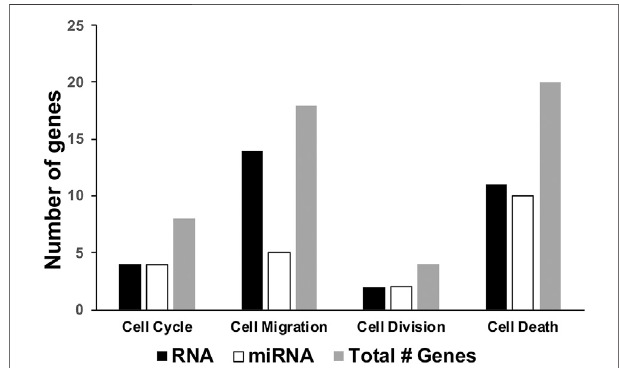
FIGURE 5 | Number of differentially expressed genes related to neurogenesis in brains of C1KO mice as compared to WT mice. The number of differentially expressed genes, based on RNA sequencing or miRNA- targeted or both, were compiled for cell cycle, cell migration, cell division or cell